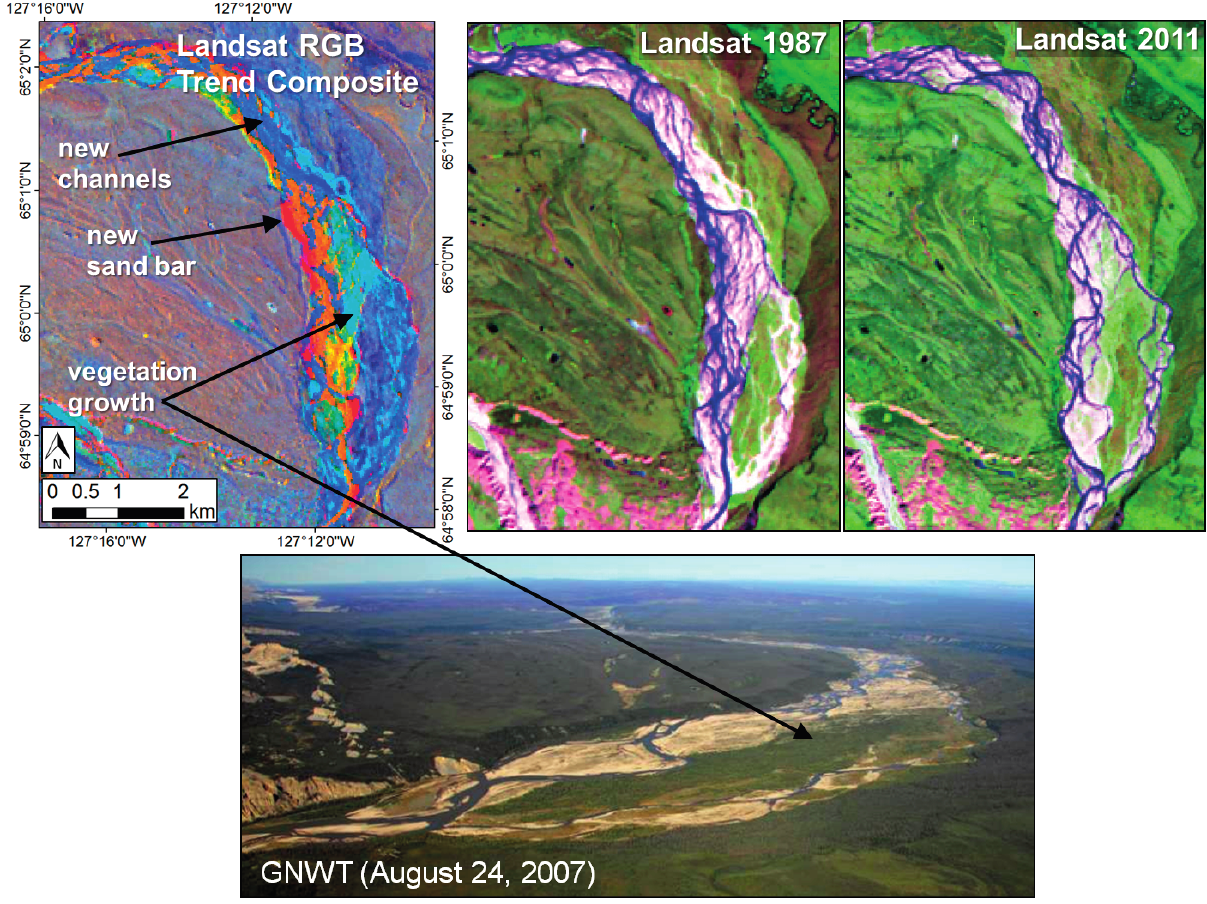
Figure 12. TC trend image for a wide, braided river channel in the Mackenzie Mountain foothills west of Norman Wells ( upper left ). Comparison to single-date Landsat imagery ( upper middle , upper right ) and NWT air photos ( bottom ) show that the TC trends capture dynamic changes resulting from the shifting of stream channels and loss or gain of